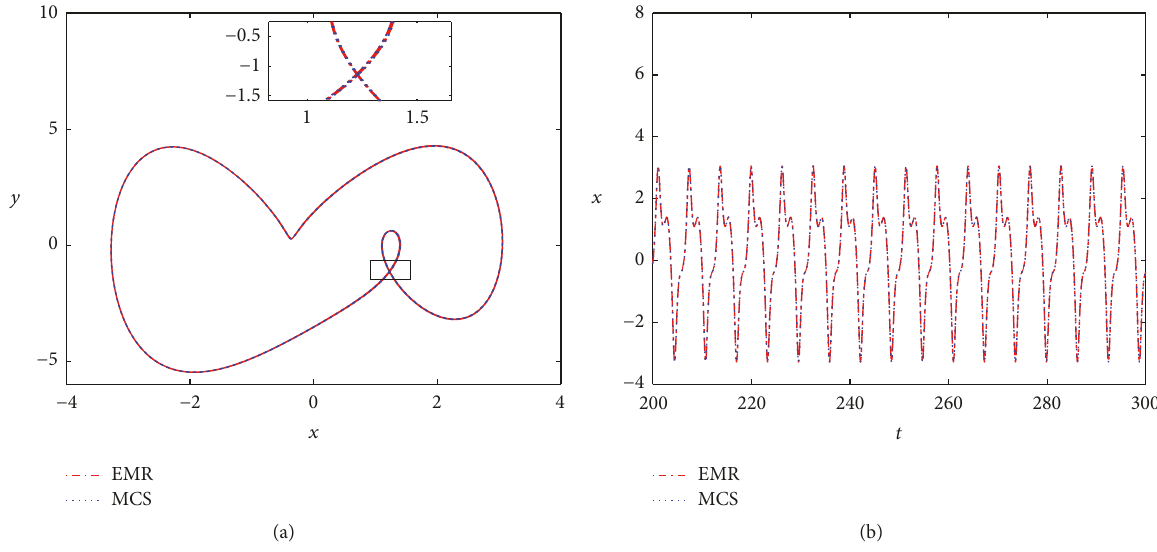
Figure 7: Period 1 𝑇 for 𝜎 = 0.01 : (a) phase portrait for EMR-MCS; (b) time history diagram for EMR-MCS.